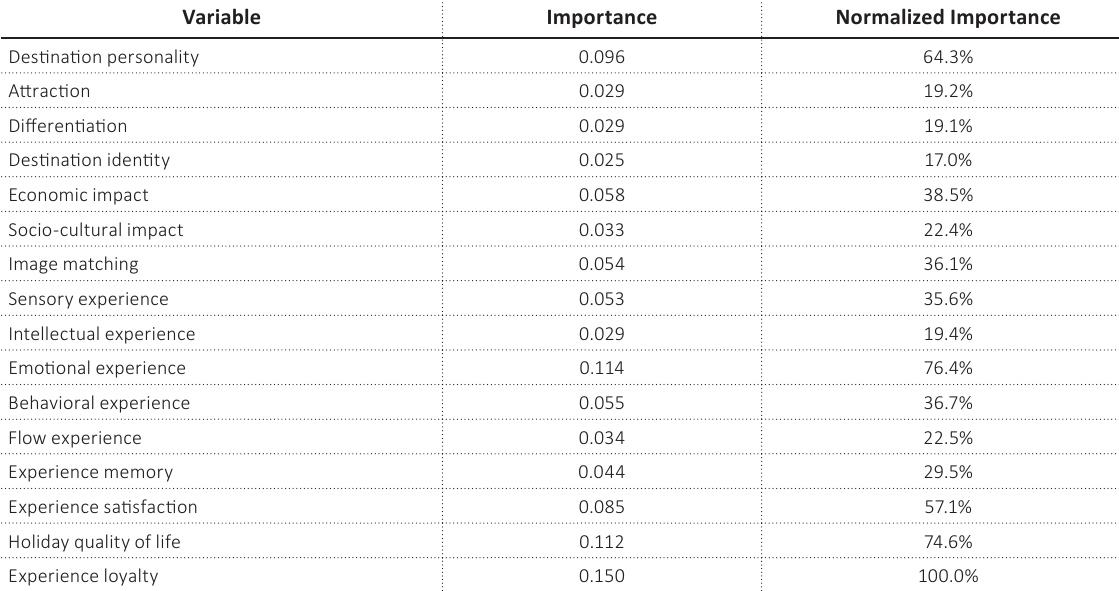
Table 4. Independent variable